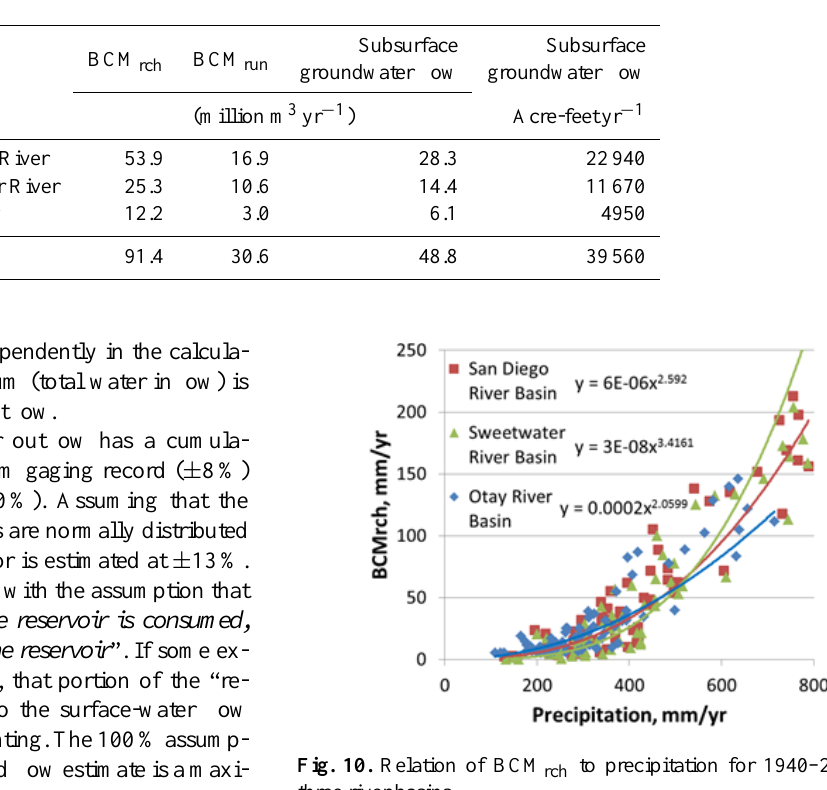
Table 9. Recharge and runoff derived from the Basin Characterization Model for 1940–2009 for the San Diego, Sweetwater, and Otay River basins and proportion of subsurface groundwater flow to the coastal plain, calculated as 40 percent of total BCM rch +BCM run for each basin, San Diego region, California.